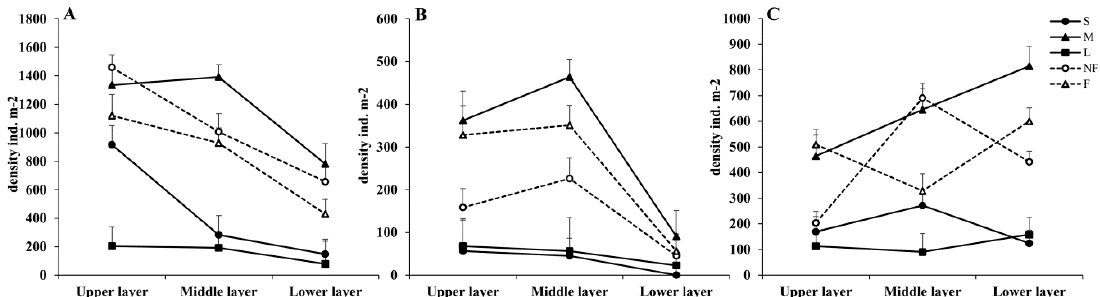
Figure 5. Vertical distribution of the body length and furcula length of the springtail in ( A ) spring, ( B ) summer, and ( C ) autumn. S = the small-sized Collembola, M = the medium-sized Collembola, L = the large-sized Collembola, NF = the Collembola with furcula < 0.1 mm, F = the Collembola with furcula > 0.1 mm. The values are the means ± SE.